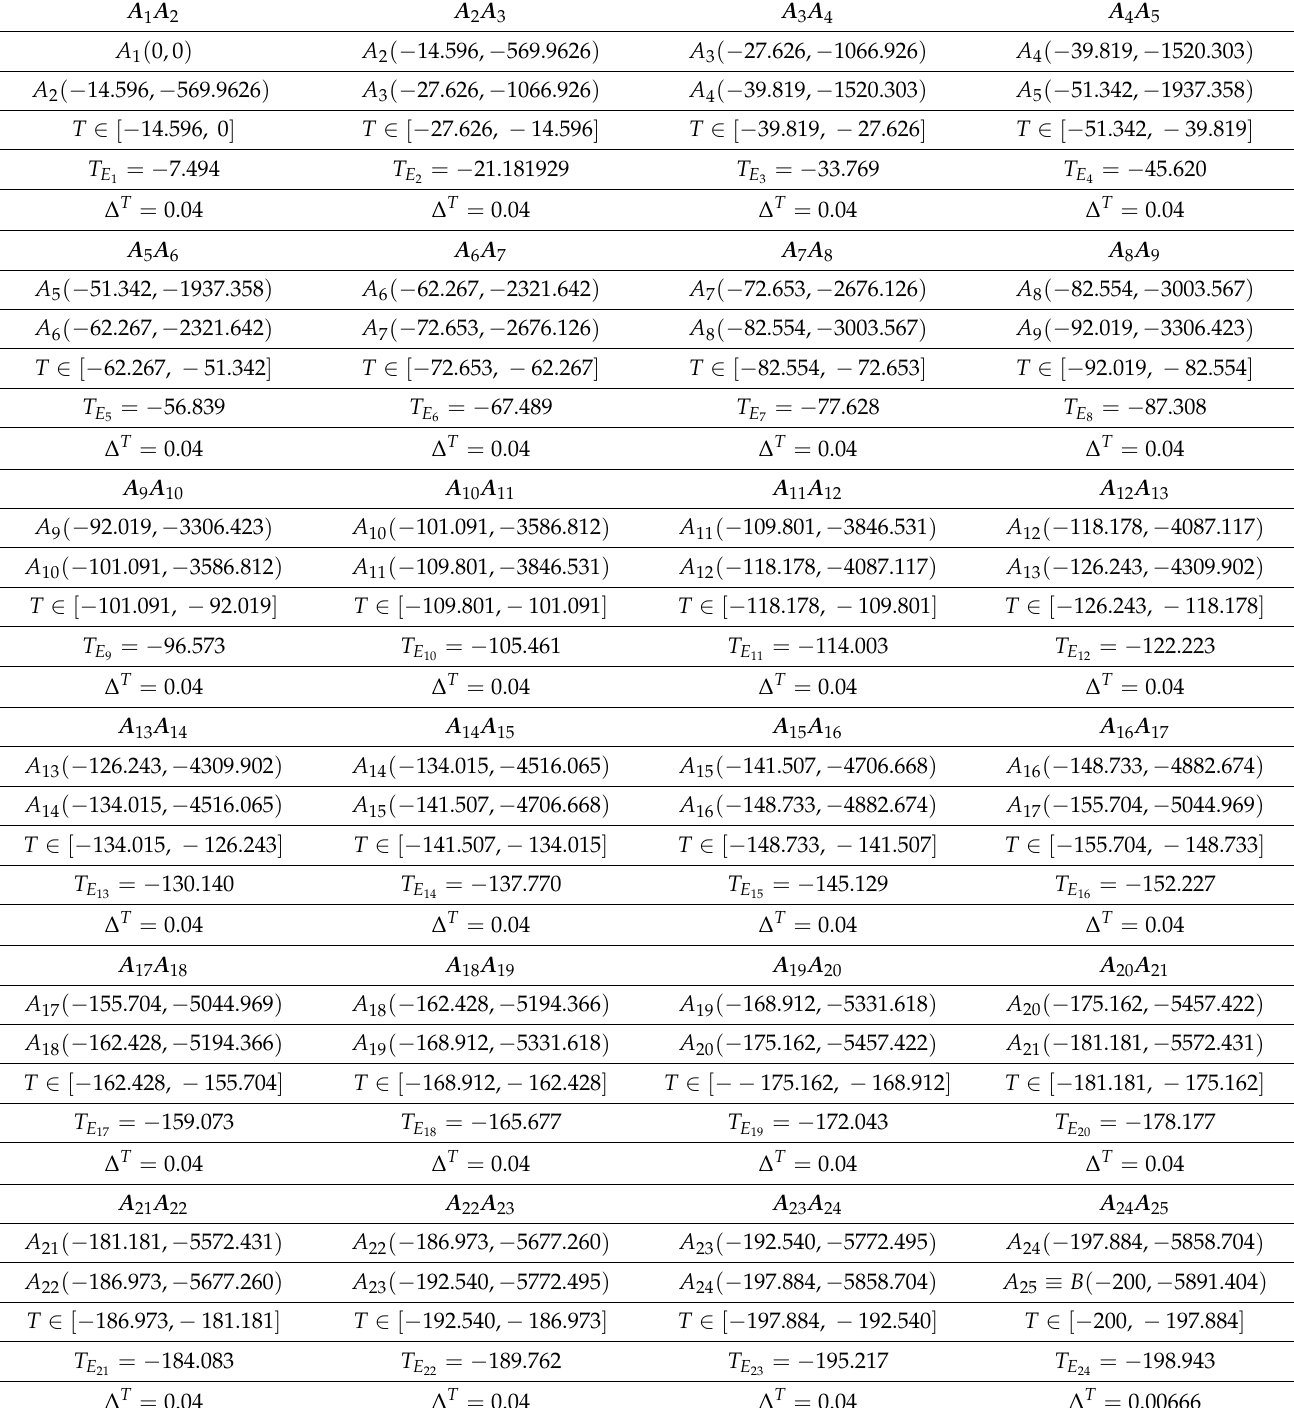
Table 4. Results in the range T ∈ [ − 200, 0 ] ◦